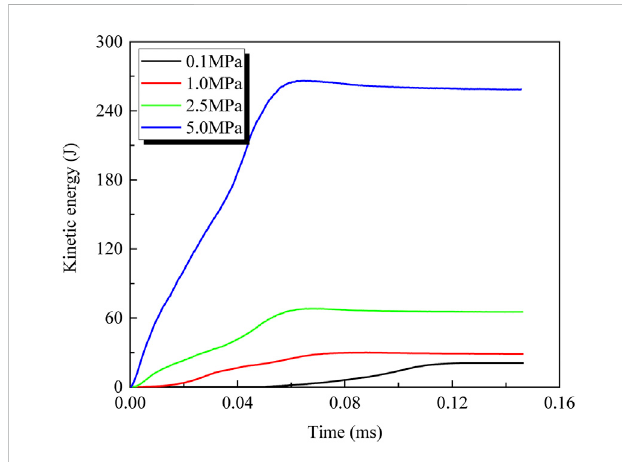
FIGURE 9 Change in kinetic energy vs time for different pre-con fi ning